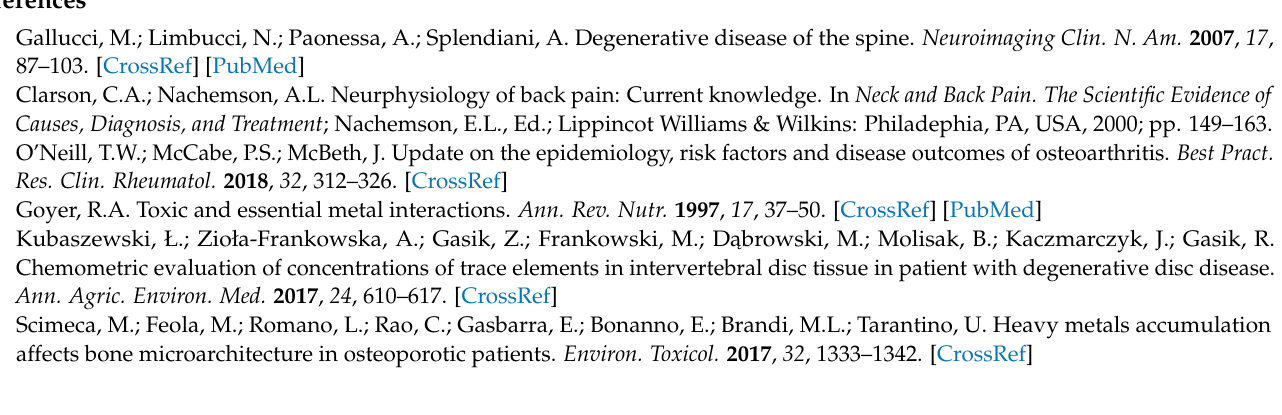
Table S4: Correlation coefficients between age, BMI, VAS and concentrations of mineral components in the serum (Ca, Mg), blood (Pb, Cd, Hg); Table S5: Correlation coefficients between age, BMI, VAS and fat/water ratio in selected structures of the spine; Table S6: Correlation coefficients between concentrations of mineral components in the serum (Ca, Mg), blood (Pb, Cd, Hg) and fat/water ratio in selected structures of the